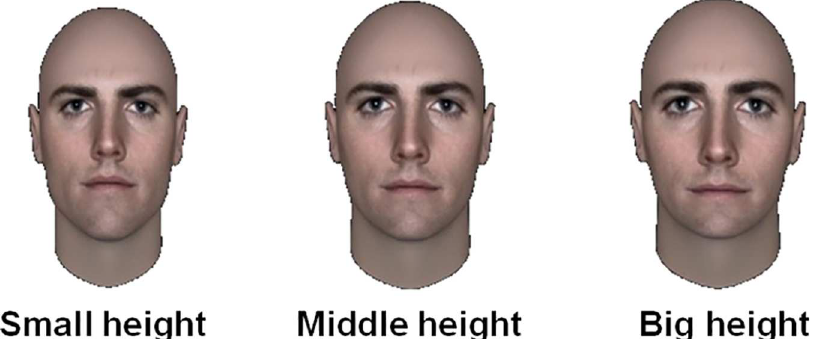
Fig 1. Can faces with the same fWHR trigger different social perception, i . e . who is more trustworthy, less aggressive or more feminine? Example of three faces selectedfrom the databaseused in the present study. These faces have the same facial width to height ratio (fWHR) obtained by differentlycombinedupper facial height and